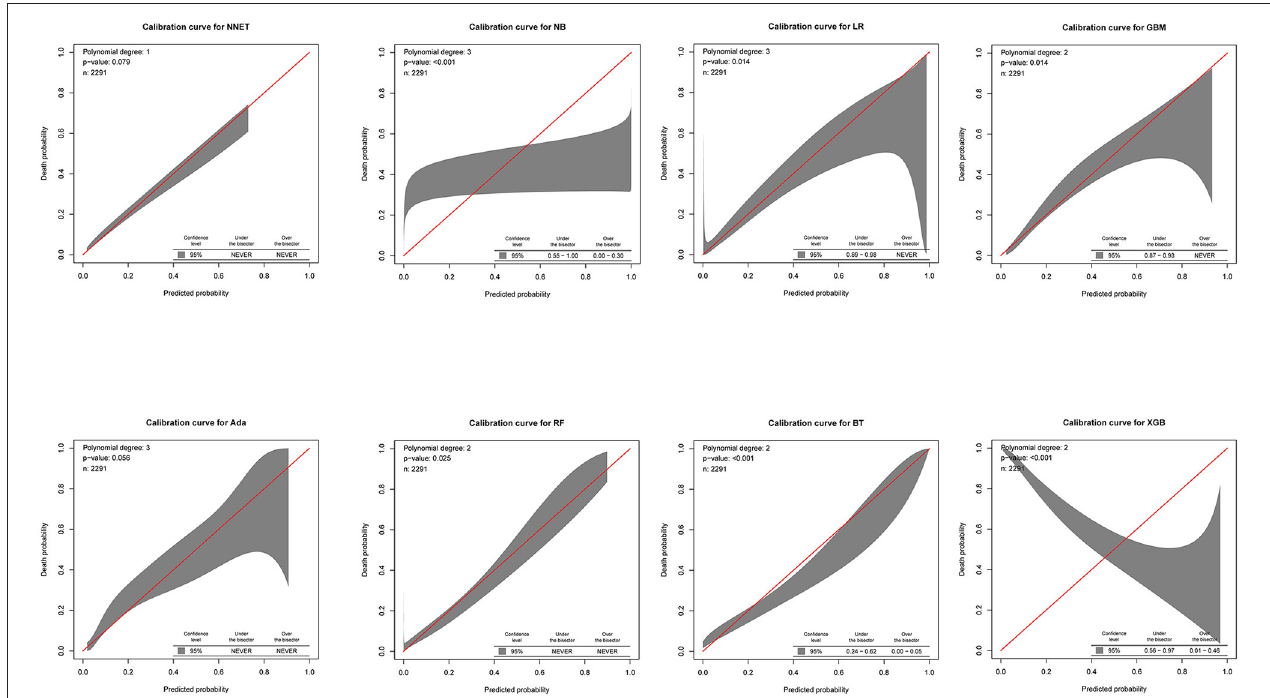
FIGURE 5 | Calibration plots of the eight models. NNET, artificial neural network; NB, naïve bayes; GBM, gradient boosting machine; Ada, adapting boosting; RF, random forest; BT, bagged trees; XGB, eXtreme Gradient Boosting; LR, logistic regression.